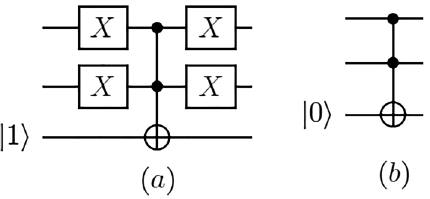
Figure 4. OR ( a ) and AND ( b ) operations of two Boolean variables.